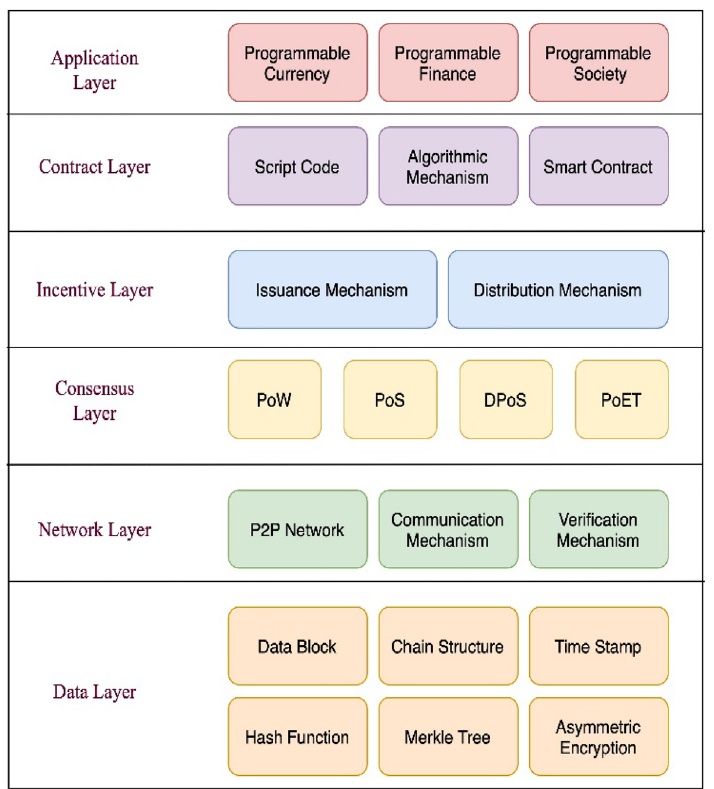
Figure 1. The layered infrastructure of blockchain technology 8